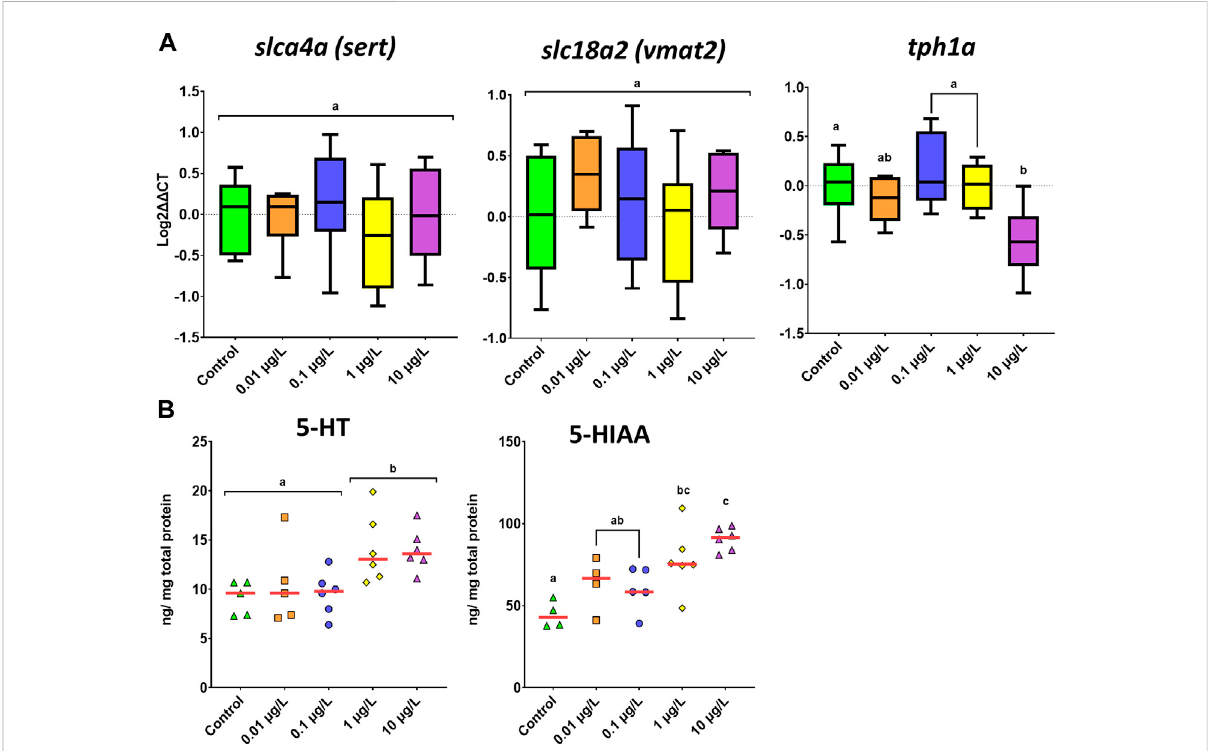
FIGURE 4 Effects on the serotonergic system of zebra fi sh larvae following developmental exposure to different concentrations of SER. Data were reportedasboxplotsorscatterplots(redline — median),forgeneexpression (A) orneurochemicallevels (B) ,respectively. One-wayANOVAfollowed by Tukey multiple comparison test was used for gene expression ( n = 6 – 8), whereas Kruskal Wallis test was used for neurochemical analyses ( n = 4 – 6). Different letters represent different subset